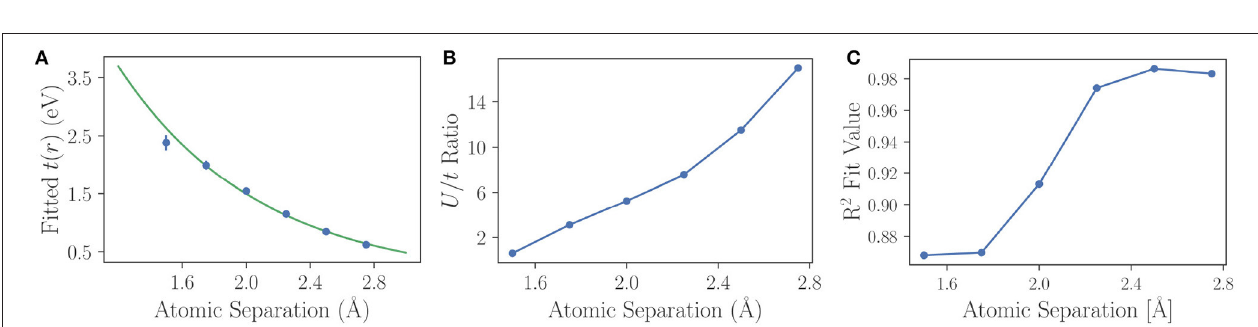
FIGURE 8 | (A) The one-body hopping t parameter as a function of interatomic distance for the periodic H 10 chain, obtained from a fitted U - t model. t declines to zero as r increases. (B) The ratio U / t for the fitted parameter values as a function of interatomic separation. The ratio is small at lower bond-lengths, where t is more relevant in describing the system, and larger at longer bond-lengths, where inter-site hopping is less significant. (C) The R 2 fit parameters obtained from fitting the U - t model to the H 10 chain, as a function of interatomic